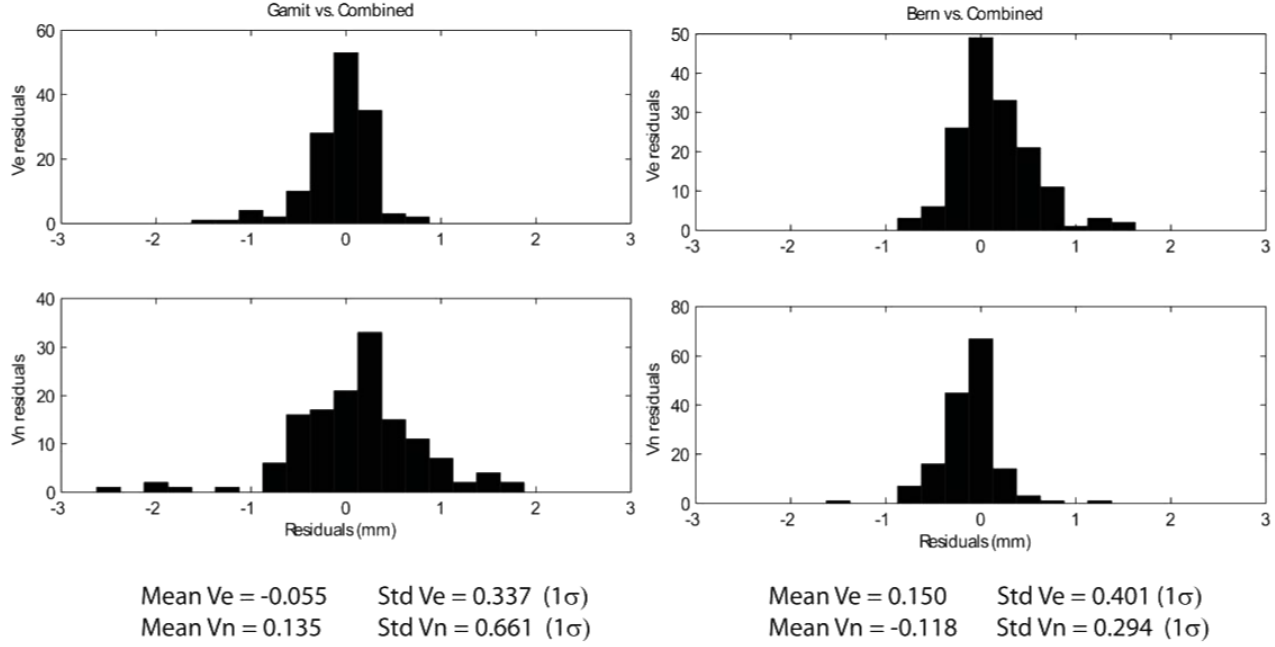
Figure 3. Residuals distributions between the combined and individual Bernese (Bern) and GAMIT (Gamit)